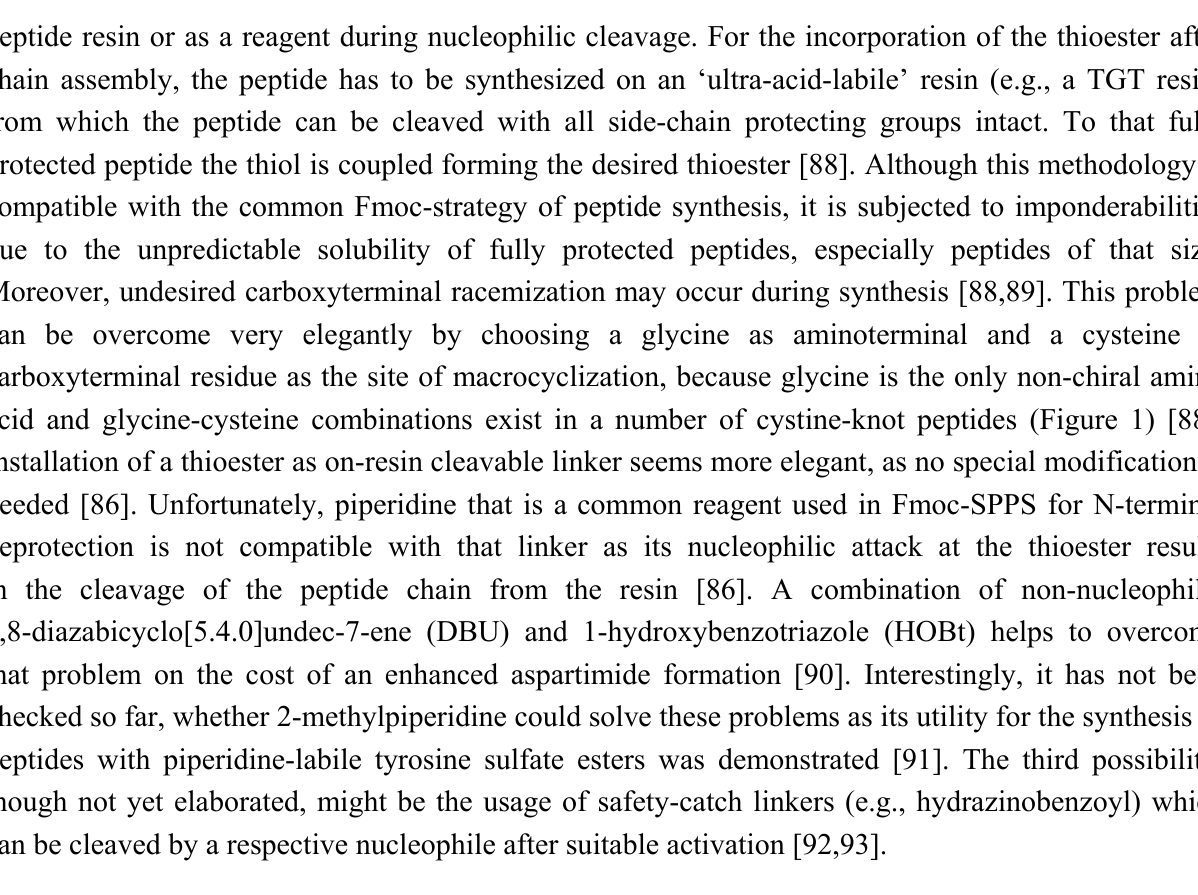
Figure 5. Proposed cyclization via native chemical